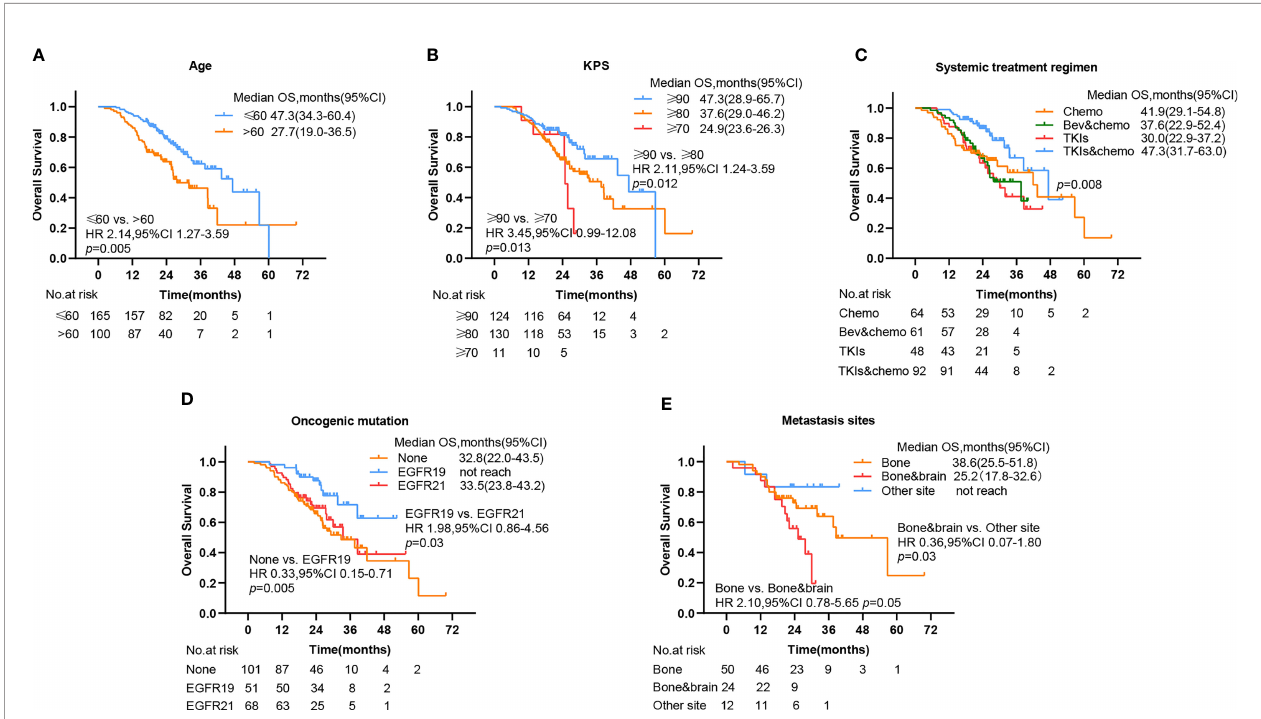
FIGURE 4 | Kaplan – Meier plots show percent overall survival categorized by (A) age, (B) KPS, (C) systemic treatment regimen, (D) oncogenic mutation, and (E) metastasis sites, with numbers at risk shown below the graph. PFS, progression-free survival; OS, overall survival, CI, con fi dence interval, Bev, bevacizumab; chemo, chemotherapy; TKIs, tyrosine kinase